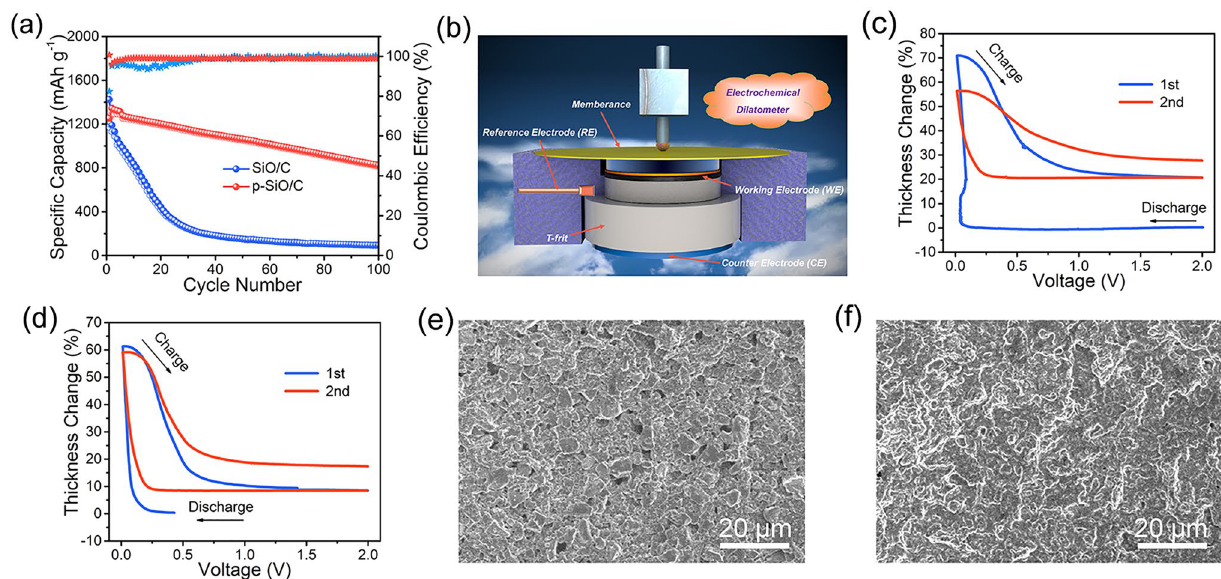
Fig. 5 a Cycle performances of SiO/C and p-SiO/C anode. b Schematic diagram of the in-situ electrochemical dilatometry. c Voltage-thickness curves of SiO/C and d p-SiO/C anodes. SEM images of e SiO/C and f p-SiO/C